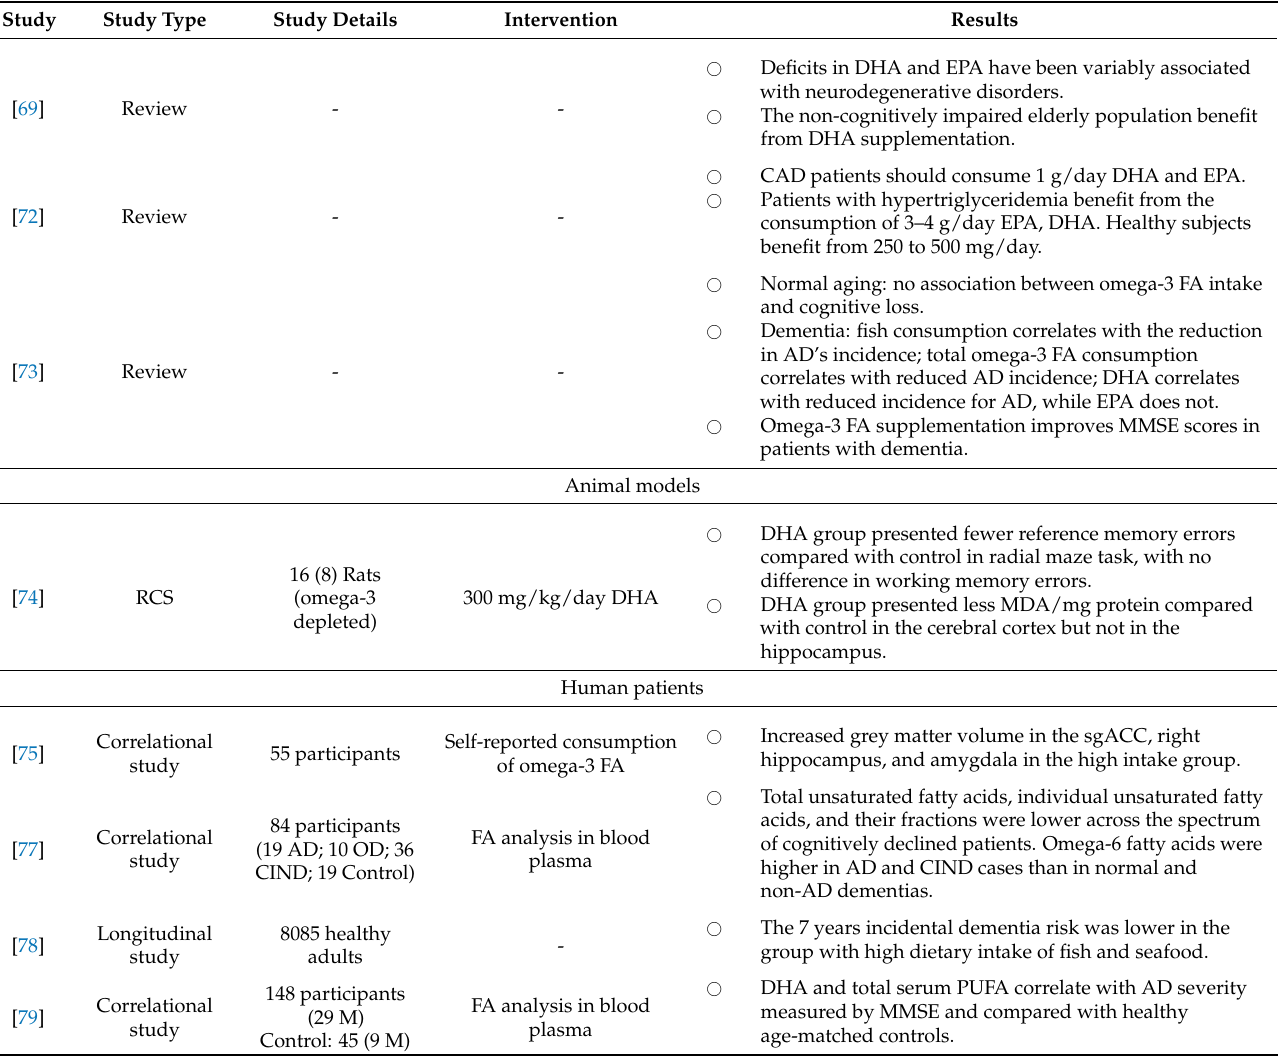
Table 2. The correlation between AD and fatty acids neuroprotective